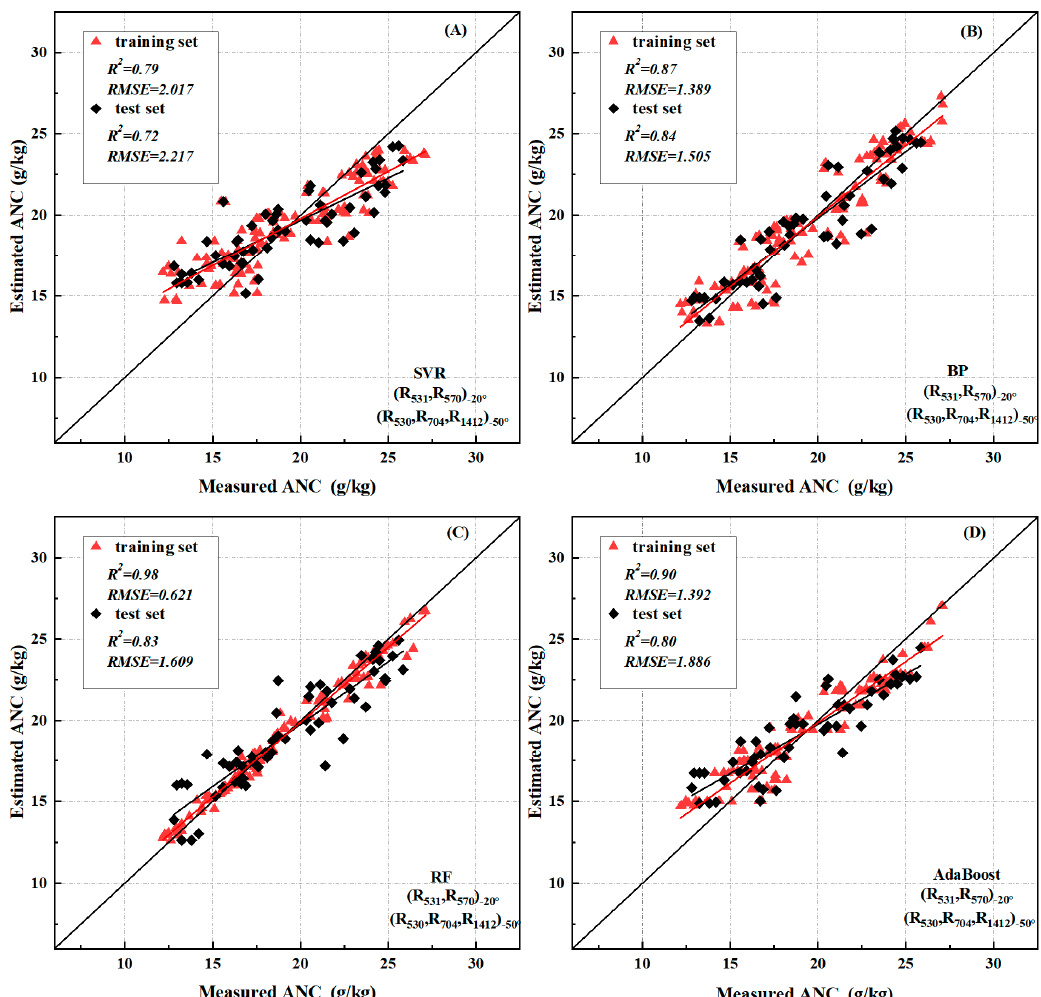
Figure 12. Machine learning modeling based on the spectral index AINI − 50° ’s 530 nm, 704 nm, 1412 nm bands and PRI − 20° ’s 531 nm, 570 nm bands (n = 180, training set = 126, validation set = 54): ( A ) SVR, ( B ) BP, ( C ) RF, ( D ) AdaBoost.